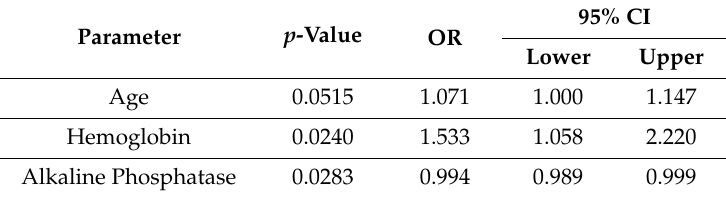
Table 3. Clinical factors associated with PSA decline >20% by univariate analysis.